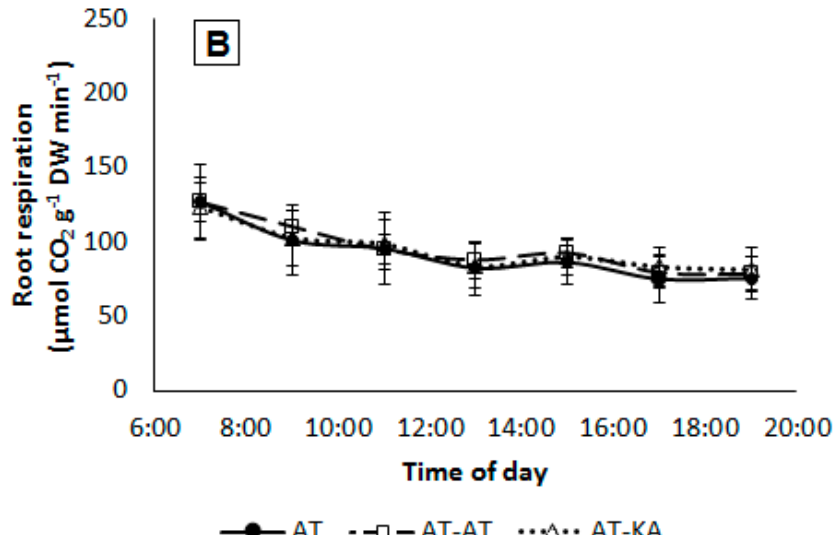
Figure 5. Daily time-course of root respiration in plants from each treatment growing under medium ( A ) or high ( B ) light intensity. Measurements started one hour before the lights turned on until one hour after the lights turned off. Symbols represent mean ± SE of eight replicates. AT: Non-grafted treatment; AT-AT: Homograft; and, AT-KA: Graft treatment.